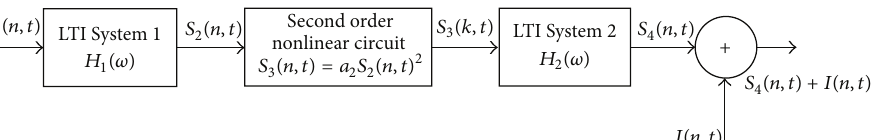
Figure 1: Block diagram of the harmonic step-frequency radar model with added deterministic interference. This model is adapted from [29] for distortion prediction of nonlinear